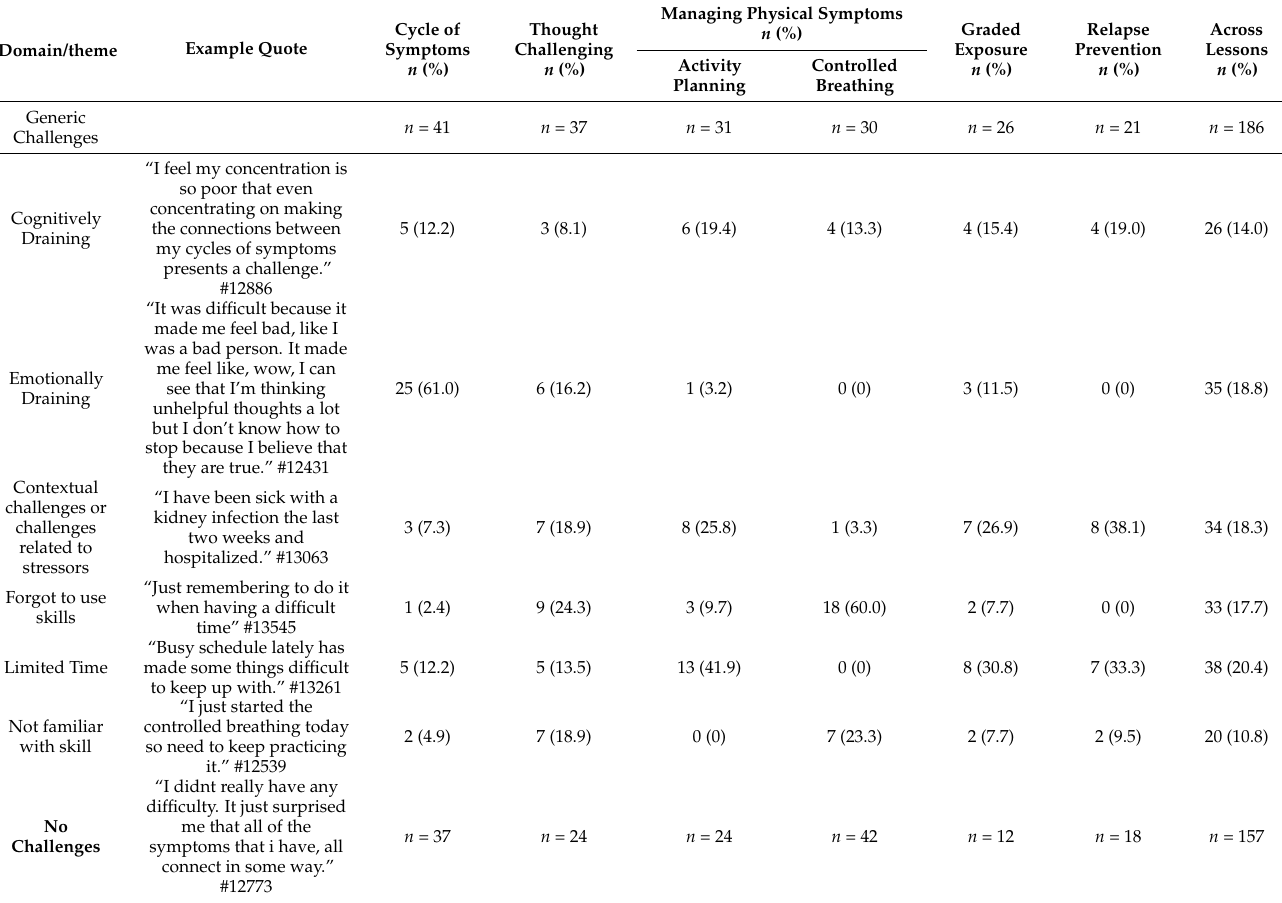
Table 4. Generic challenges per skill and no